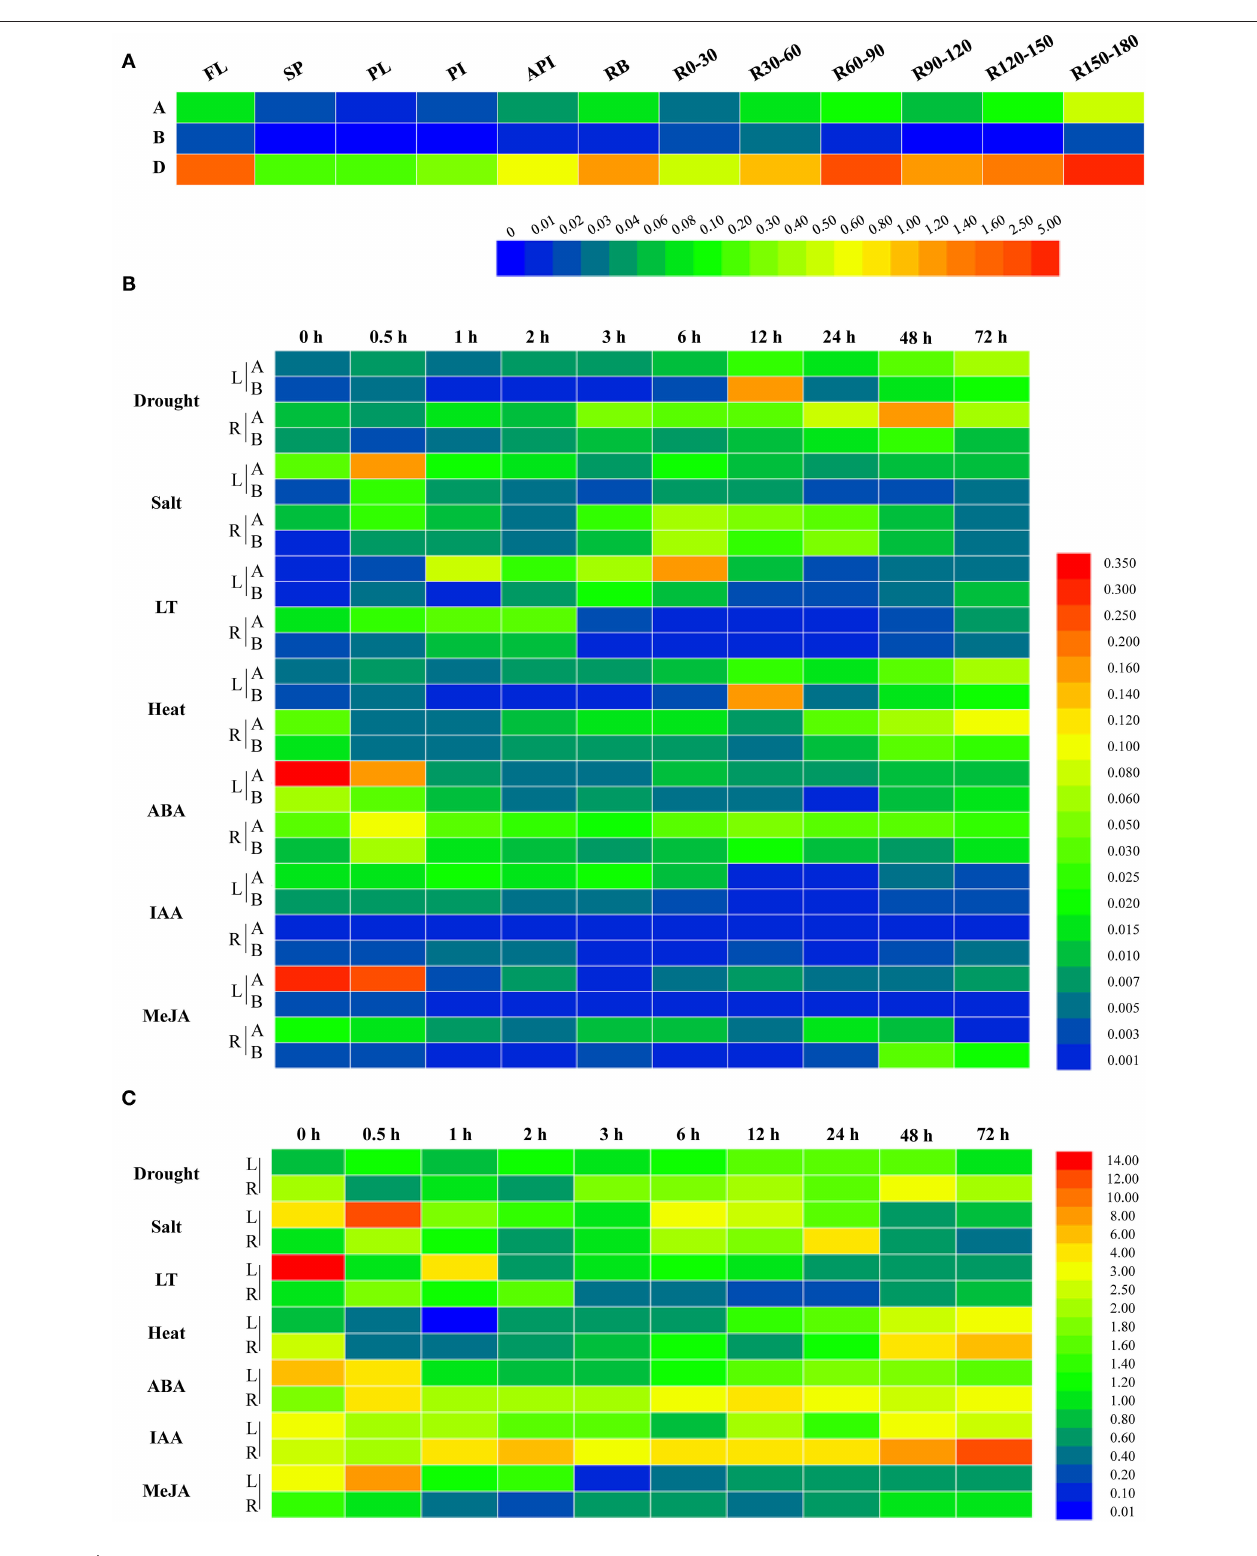
Frontiers in Plant Science |